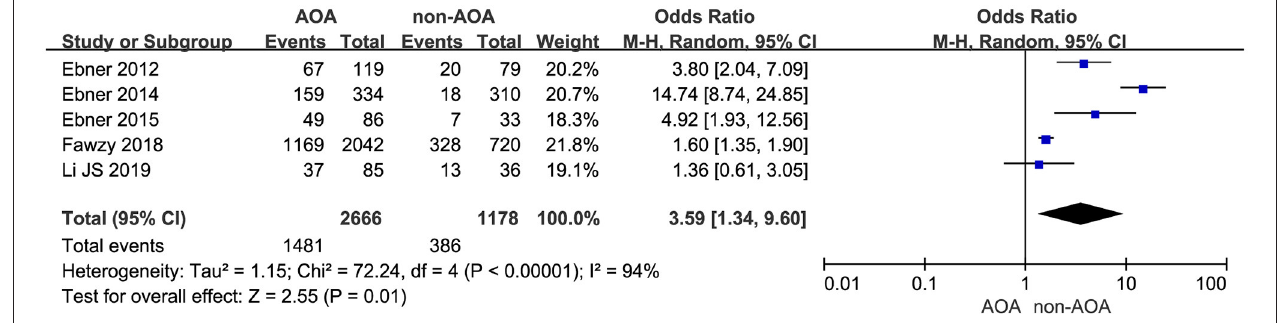
FIGURE 7 | Forest plot of blastocyst formation rate between AOA treatment and non-AOA treatment patient groups using calcium